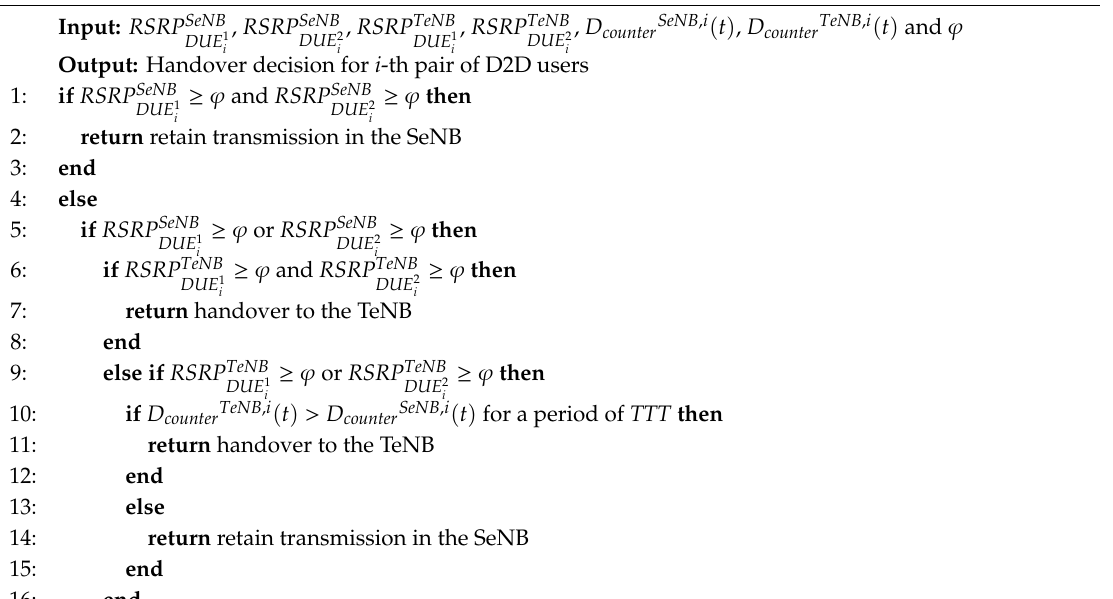
Algorithm 2 Handover Decision